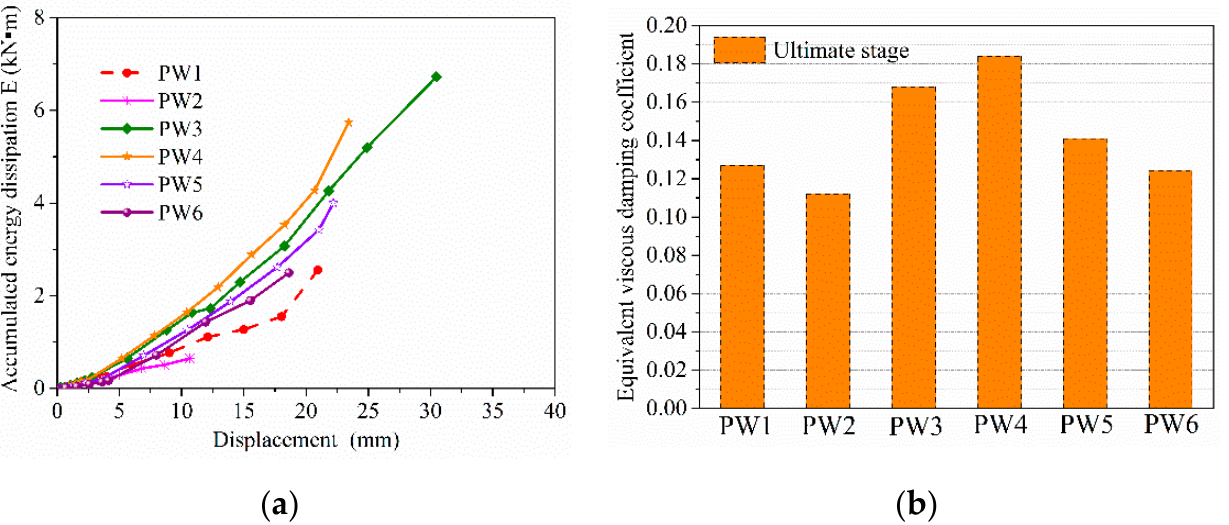
Figure 15. Energy dissipation and equivalent viscous damping coefficient of PW1–PW6: ( a ) rela- tionship curves between the accumulated energy dissipation and displacement load and ( b ) the equivalent viscous damping coefficient for PW1–PW6 in the ultimate state.